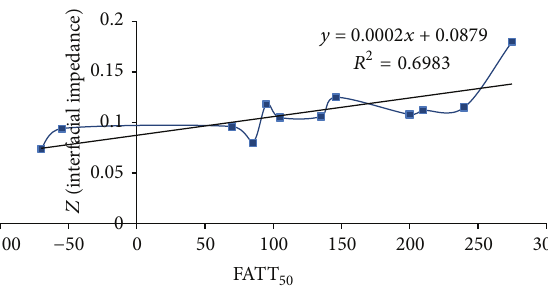
Figure 5: Relationship of interface impedance and FATT 50 values.